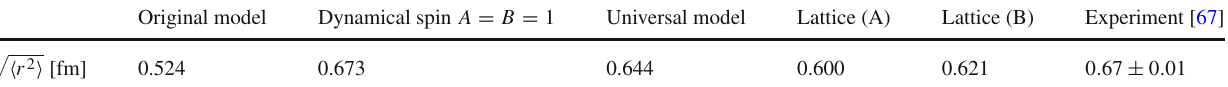
Table 1 Values of the pion mean radius, Eq. (26), obtained within the lattice and the models based on the the AdS/QCD approach. Experimental data are from Ref. [67]